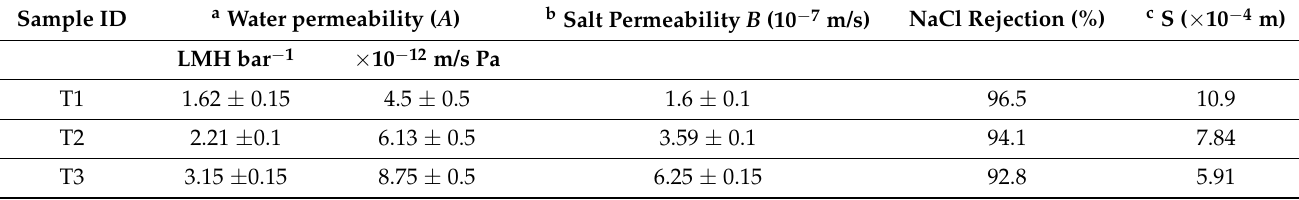
Table 4. Membrane samples transport properties and structural